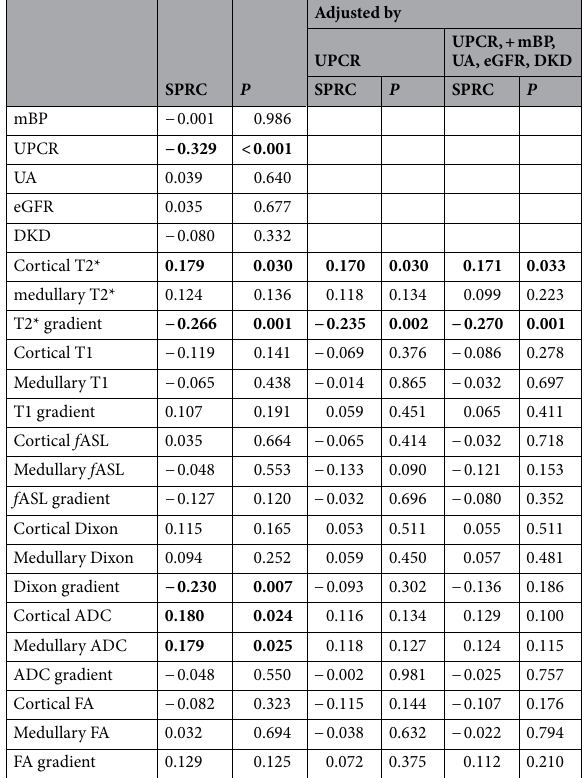
Table 3. Multivariate analysis of the association between eGFR slope and individual variables. Multivariate analysis was used for the association between eGFR slope and each variable. mBP mean blood pressure, UPCR urinary protein creatinine ratio, UA uric acid, DKD diabetic kidney disease, fASL perfusion volume estimated by arterial spin labelling, Dixon signal intensity of Dixon water image, ADC apparent diffusion coefficients, FA fractional anisotropy, SPRC standardized partial regression coefficients, P value < 0.05 was considered significant (bold). Objective variable: eGFR slope. All results were adjusted for age and gender.